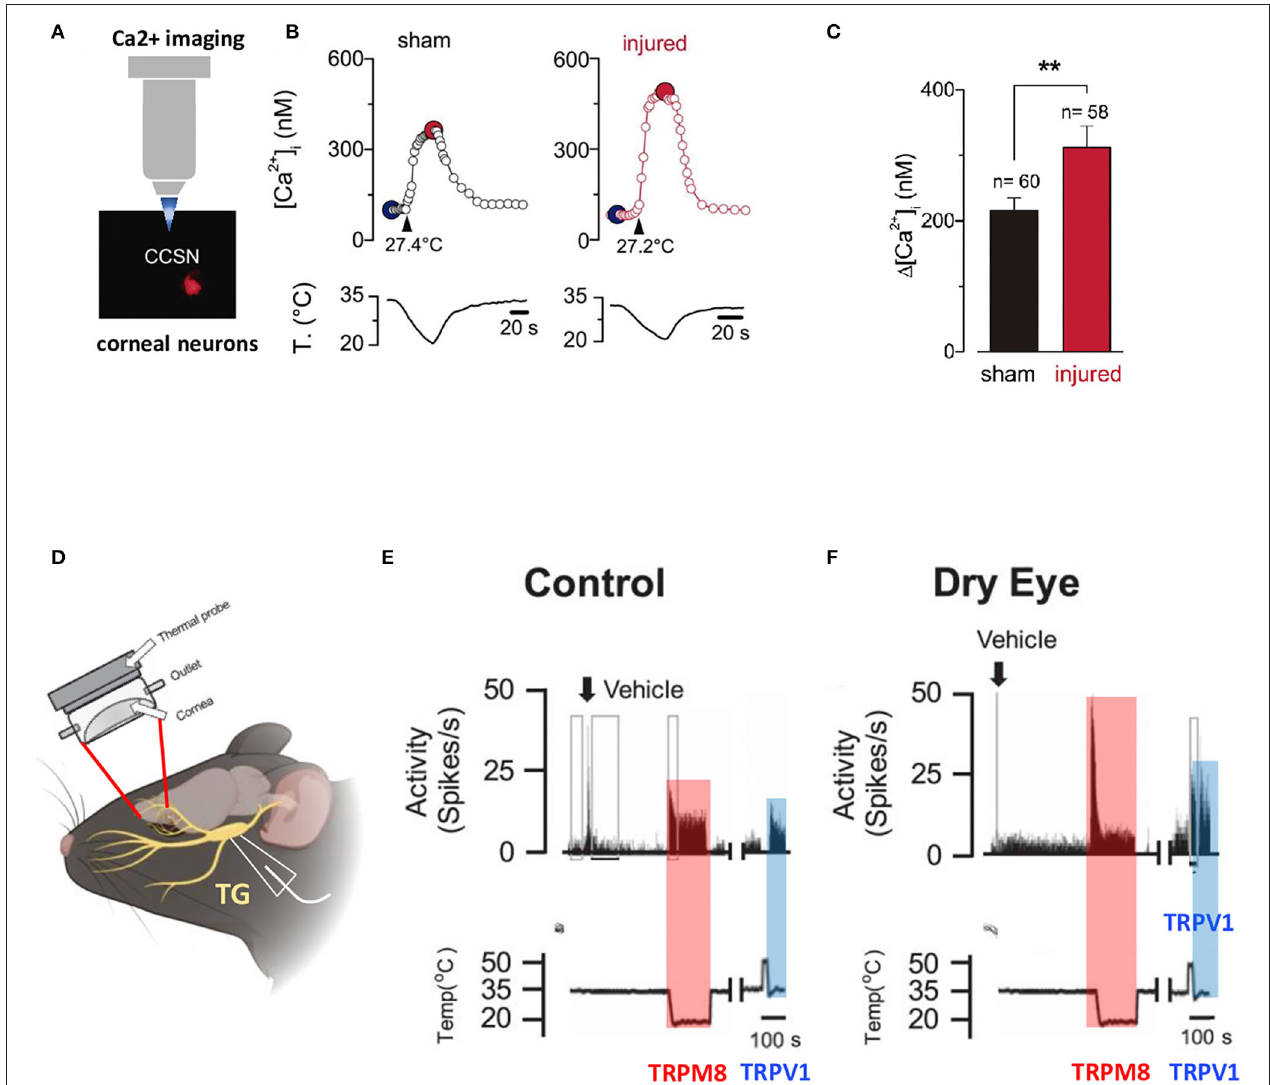
FIGURE 3 | Altered responsiveness of corneal neurons following peripheral nerve damage and after lacrimal gland excision. (A) Altered cold sensitivity of corneal neurons induced by peripheral nerve damage. Calcium imaging on FM 1–43 labeled corneal neurons in culture. (B) Cold-evoked [Ca 2 + ]i response to a temperature ramp of two representative corneal neurons from sham (black trace) and injured (red trace) mice. Large dots indicate the basal (blue) and maximal (red) [Ca 2 + ]i during the cold stimulus. (C) Bar graphs of the mean amplitude of [Ca 2 + ]i rises evoked by cold stimulation in the corneal neurons from sham and injured mice. Modified from Pina et al. (2019). Data plotted as mean ± SEM. ** p = 0.0014. (D) Illustration of the custom-made chamber designed with inflow and outflow portals for maintaining a constant environment on the surface of the cornea while recording from neuronal cell bodies located in the TG. (E,F) Effects of vehicle and cool and heat-evoked activity in control (E) and lacrimal gland excision (LGE) animals (F) . Neuronal activity recorded from control animals and animals 2 weeks after LGE, following vehicle, cold stimulation (TRPM8 activation), and 3 µ M capsaicin (TRPV1 activation) applications to the cornea. Copyright © 2019 the American Physiological Society (Hatta et al.,